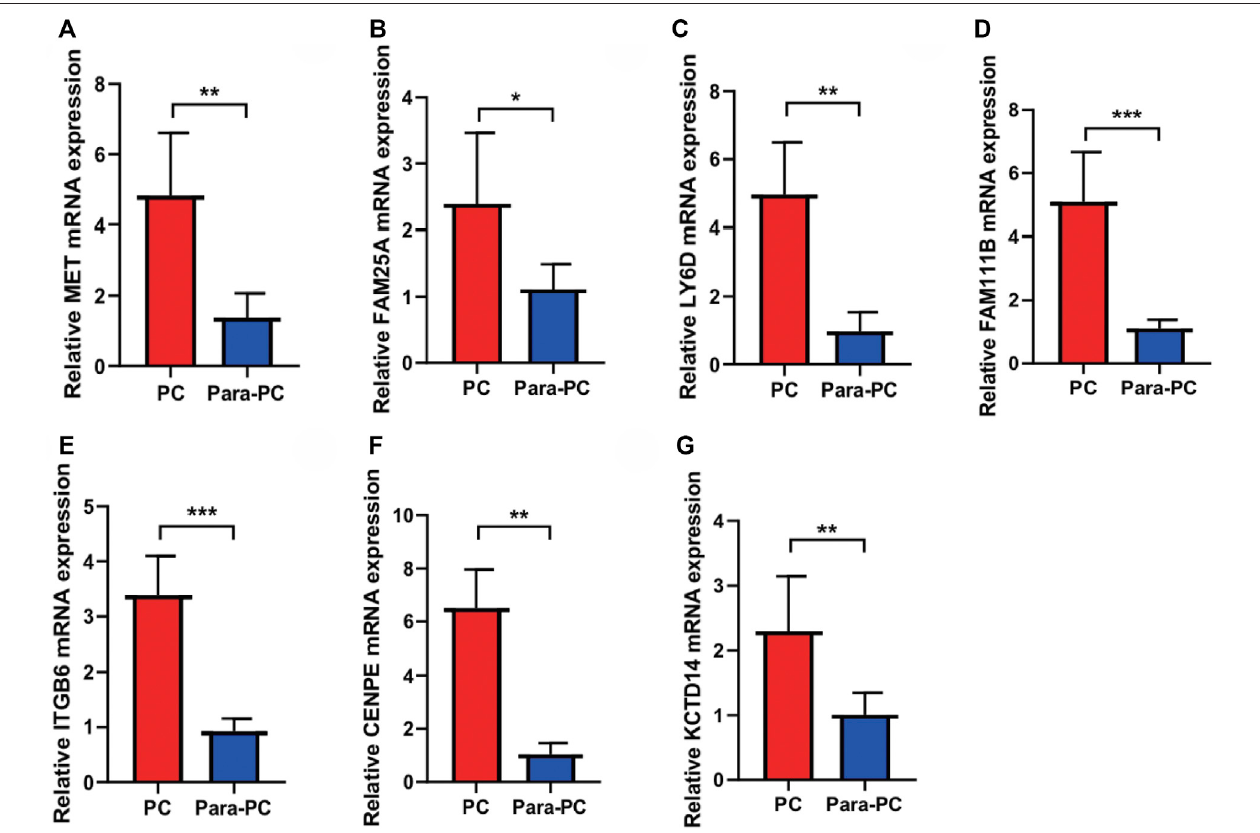
FIGURE 10 | qRT-PCR to verify the expressions of seven model genes in PC. The seven model genes were all upregulated in PC compared with the normal adjacent tissues (* p < 0.05, ** p < 0.01, and *** p < 0.001). (A) MET; (B) FAM25A; (C) LY6D; (D) FAM111B; (E) ITGB6; (F) CENPE; (G) KCTD14.